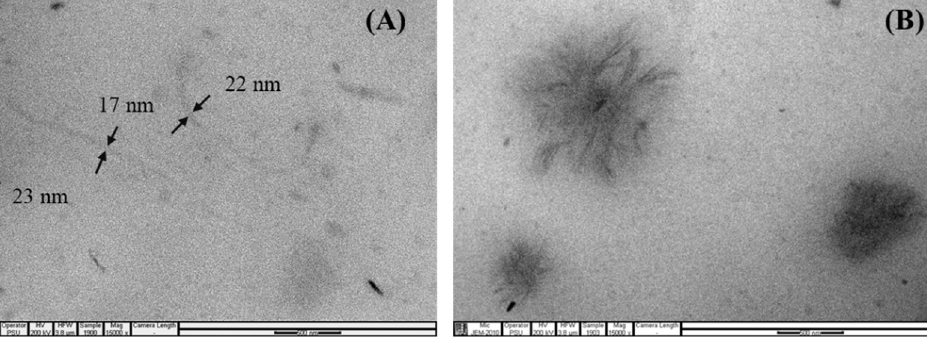
Figure 3. TEM images of ( A ) CNF1/NR and ( B ) CNF5/NR at high magnification (X15,000).